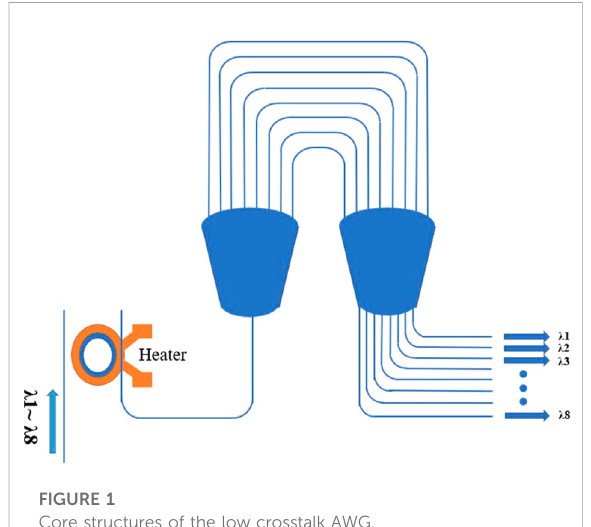
FIGURE 1 Core structures of the low crosstalk